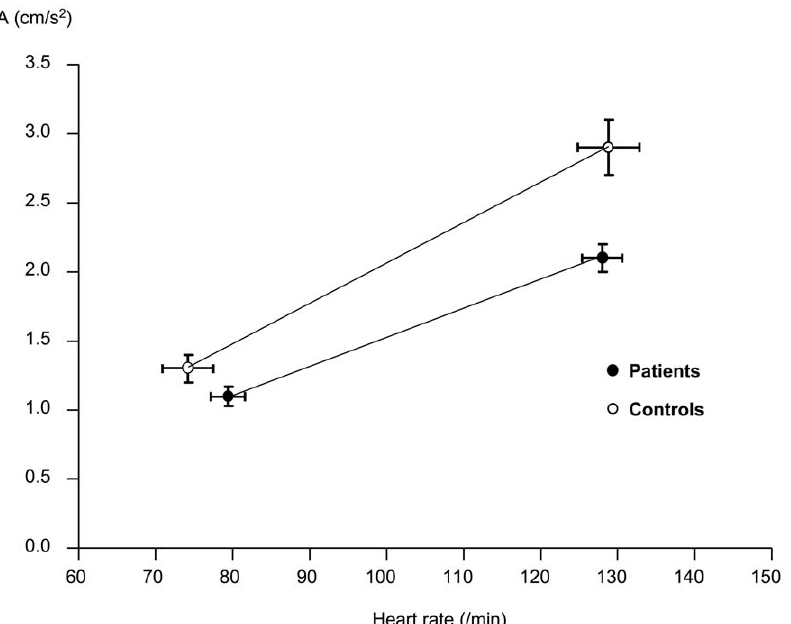
Figure 4. Line plot showing impaired contractile reserve in patients as reflected by the smaller increment of left ventricular myocardial isovolumic acceleration (IVA) with escalating heart rate during exercise in patients than controls. The error bars represent standard errors of means.